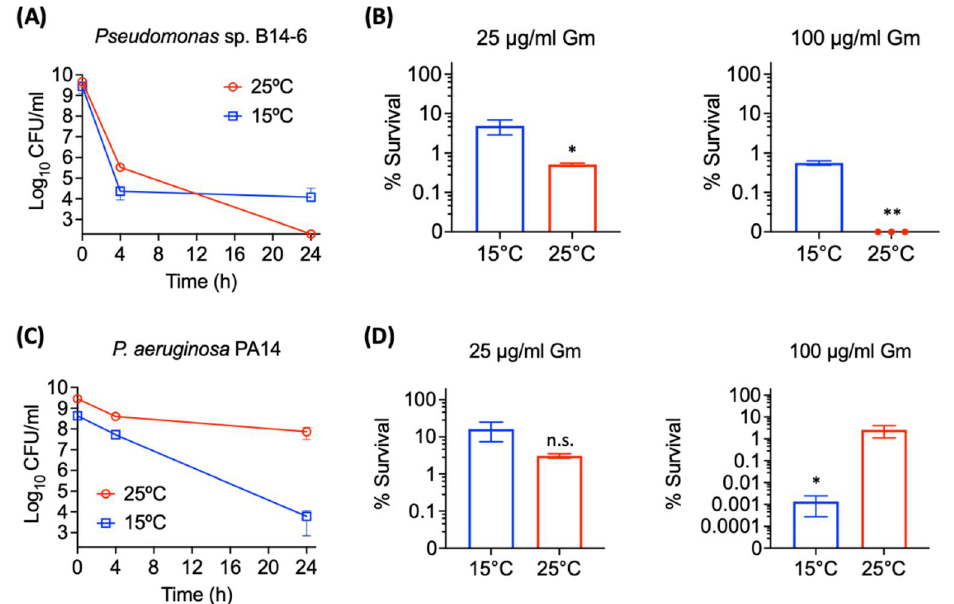
Figure 3. Aminoglycoside-tolerant population of Pseudomonas sp. B14-6 is composed of partially tolerant cells and high tolerant persisters. The overnight cultures of Pseudomonas sp. B14-6 (A) or of P. aeruginosa PA14 ( C ) were treated with or 100 µg/mL gentamicin for 24 h at 15 °C and 25 °C. The dependent viability was measured at 4 h and 24 h post treatment. Pseudomonas sp. B14-6 overnight culture ( B ) or P. aeruginosa PA14 overnight culture ( D ) were treated with 25 µg/mL gentamicin, or 100 µg/mL gentamicin for 24 h at 15 °C and 25 °C. Viability was measured by serial dilution and plating on agar plates. The data points on the x-axis ( B ) are below the level of detection (2 × 10 2 CFU/ml). Results are shown as mean ± SD; n = 3. Statistical differences were analyzed by t -test; * p < 0.05, ** p < 0.01, n.s. not significant ( p > 0.05).